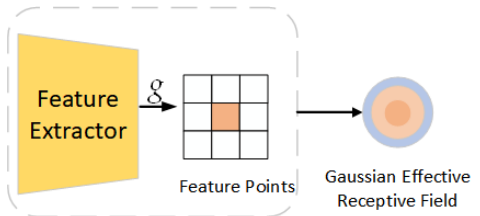
Figure 6. Feature schematic of the receptive field passing through the RFLA Gauss module. g stands for the Gaussian convolution kernel.